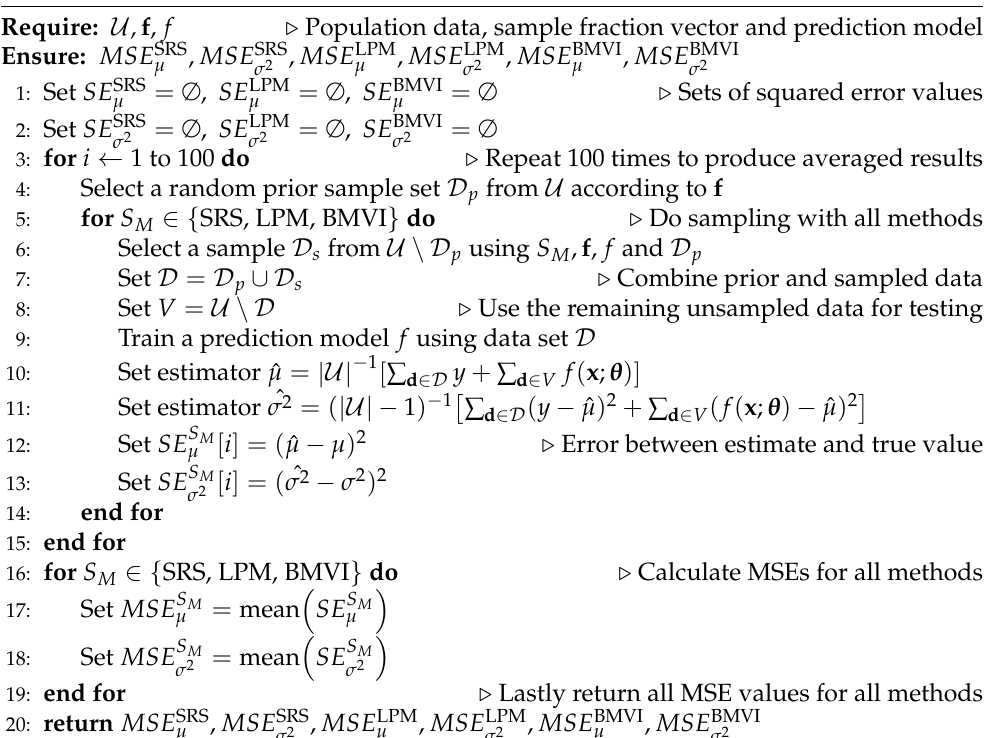
Algorithm 3 Procedure used for obtaining the empirical